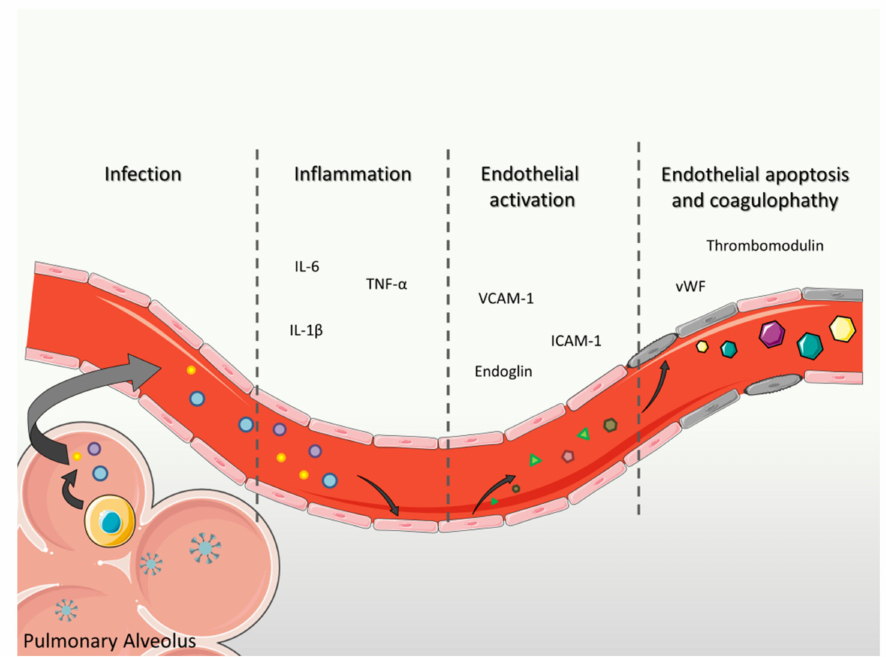
Figure 5. Temporal evolution of endothelial biomarkers in COVID-19. Increase of circulating inflammatory cytokines in response to viral infection induces alteration of endothelial cells that can be detected in term of circulating biomarkers. Early-stage inflammation is characterized by increased interleukin (IL)-1 β , tumor necrosis factor (TNF)- α , and IL-6; endothelium releases vascular adhesion molecule (VCAM)-1, intercellular adhesion molecule (ICAM)-1, and endoglin in response to inflammation; damaged endothelium releases mediators of coagulation such as thrombomodulin and von Willebrand Factor